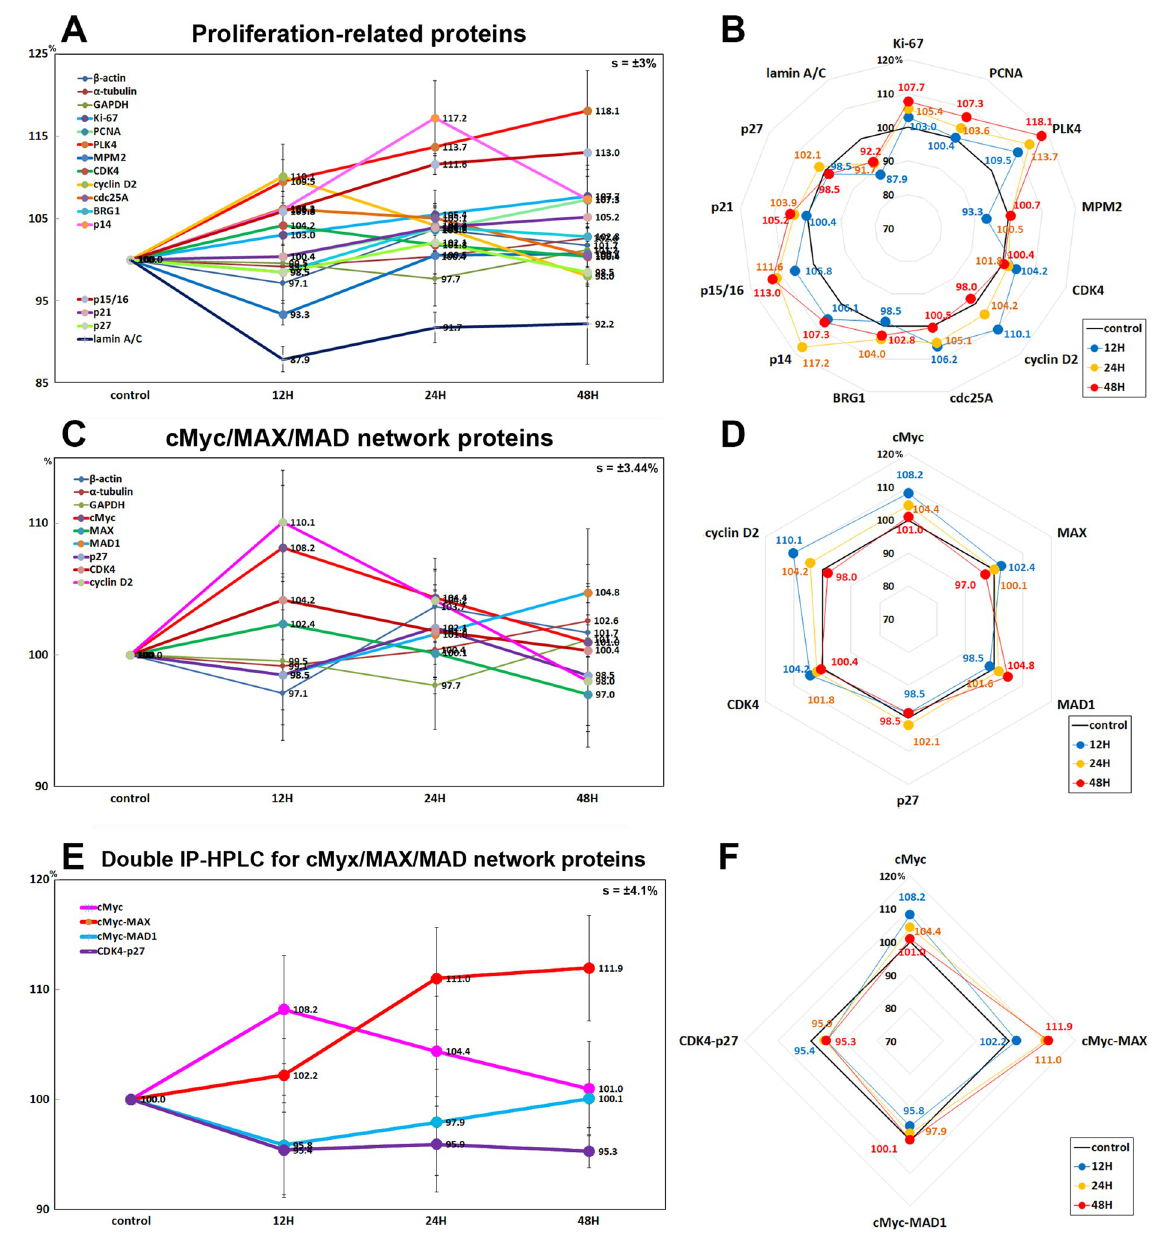
Fig 8. Expression of proliferation-related proteins (A and B), cMyc/MAX/MAD network proteins (C and D), and double IP-HPLC for cMyc/ MAX/MAD network protein complexes (E and F) in 10 μ g/mL PTX-treated RAW 264.7 cells as determined by IP-HPLC. Line graphs, A, C, and E show protein expression on the same scale (%) versus culture time (12, 24, or 48 h), whereas the star plots (B, D, and F) show the differential expression levels of the proteins at 12, 24, or 48 h after PTX treatment on the appropriate scales (%). The thick black line, untreated controls (100%); the blue, yellow, and red dots show differential protein levels after PTX administration for 12, 24, or 48 h, respectively. 24 h), adenomatous polyposis coli (APC, by 13.8% at 48 h), snail (by 13.1% at 48 h), and T-cell factor 1 (TCF1, a transcription factor, by 13.4% at 12 h) versus the untreated controls, while decreased the protein expression of snail (a transcription factor for the repression of adhesion molecule E-cadherin) by 8% at 12 h and AXIN2 (a regulator of β -catenin stability) by 8.7% at